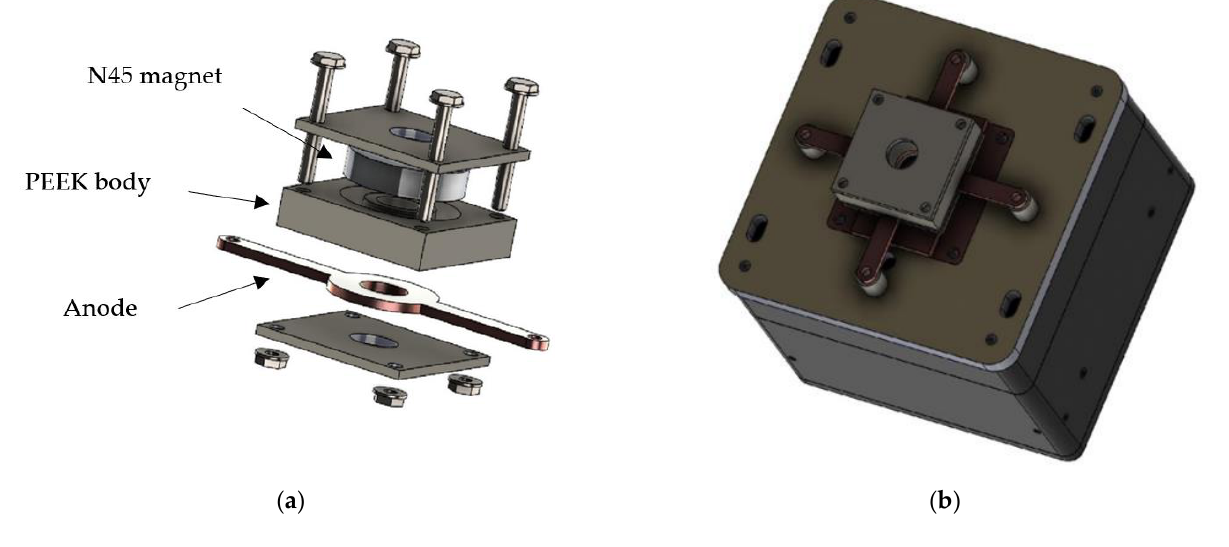
Figure 2. Magnetic nozzle used: ( a ) exposure view of the nozzle system; ( b ) CAD model of PJP with mounted magnetic nozzle.